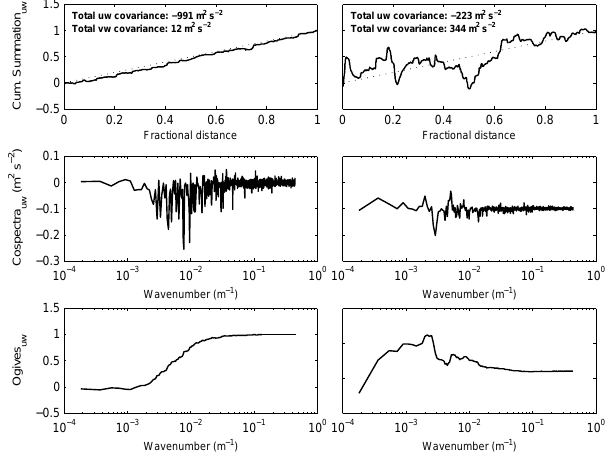
Figure A1. Quality control diagnostics for momentum flux ( u (cid:48) w (cid:48) ) . Left column shows a “good” run (Flight 181, leg 2, run 7); right column shows a “bad” run (Flight 181, leg 5, run 11). The rows show (top) the cumulative summation of u (cid:48) w (cid:48) versus distance along the run, (middle) the frequency weighted cospectra, and (bottom) the ogives (integrated cospectra) both as a function of wavenumber. The cumulative summation is normalised by the total covariance and the ogives by the total